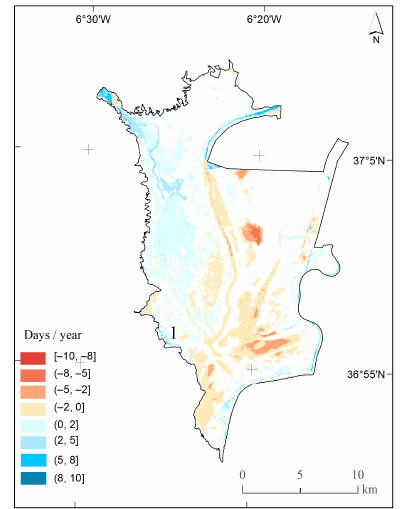
Figure 8. Theil–Sen slope in days/year for the hydroperiod time series (1974–2014). Red indicates consistent and significant decreasing trend while blue indicates the opposite. Yellowish pixels show significant but slight trends. Transparent pixels show non-significant trends. Label 1 locates Vera Sur (see text for details).